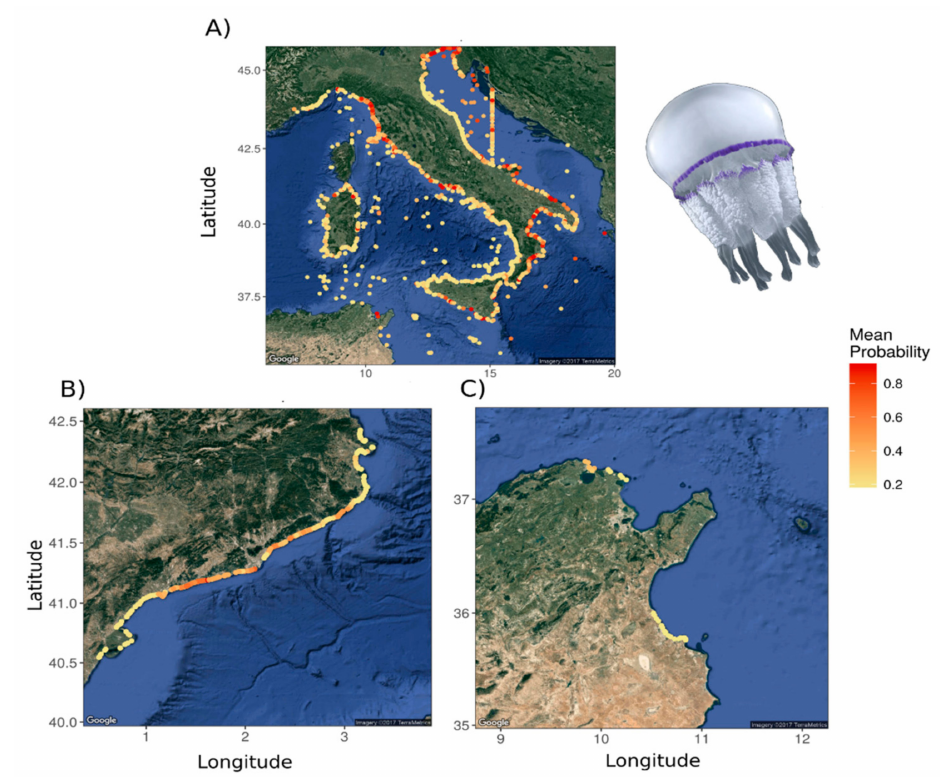
Figure 14. Ensemble modeling of the potential spatial distribution of future blooming events for Rhizostoma pulmo in ( A ) Italy (* see Section 2.1—Materials and Methods), ( B ) Spain, and ( C )